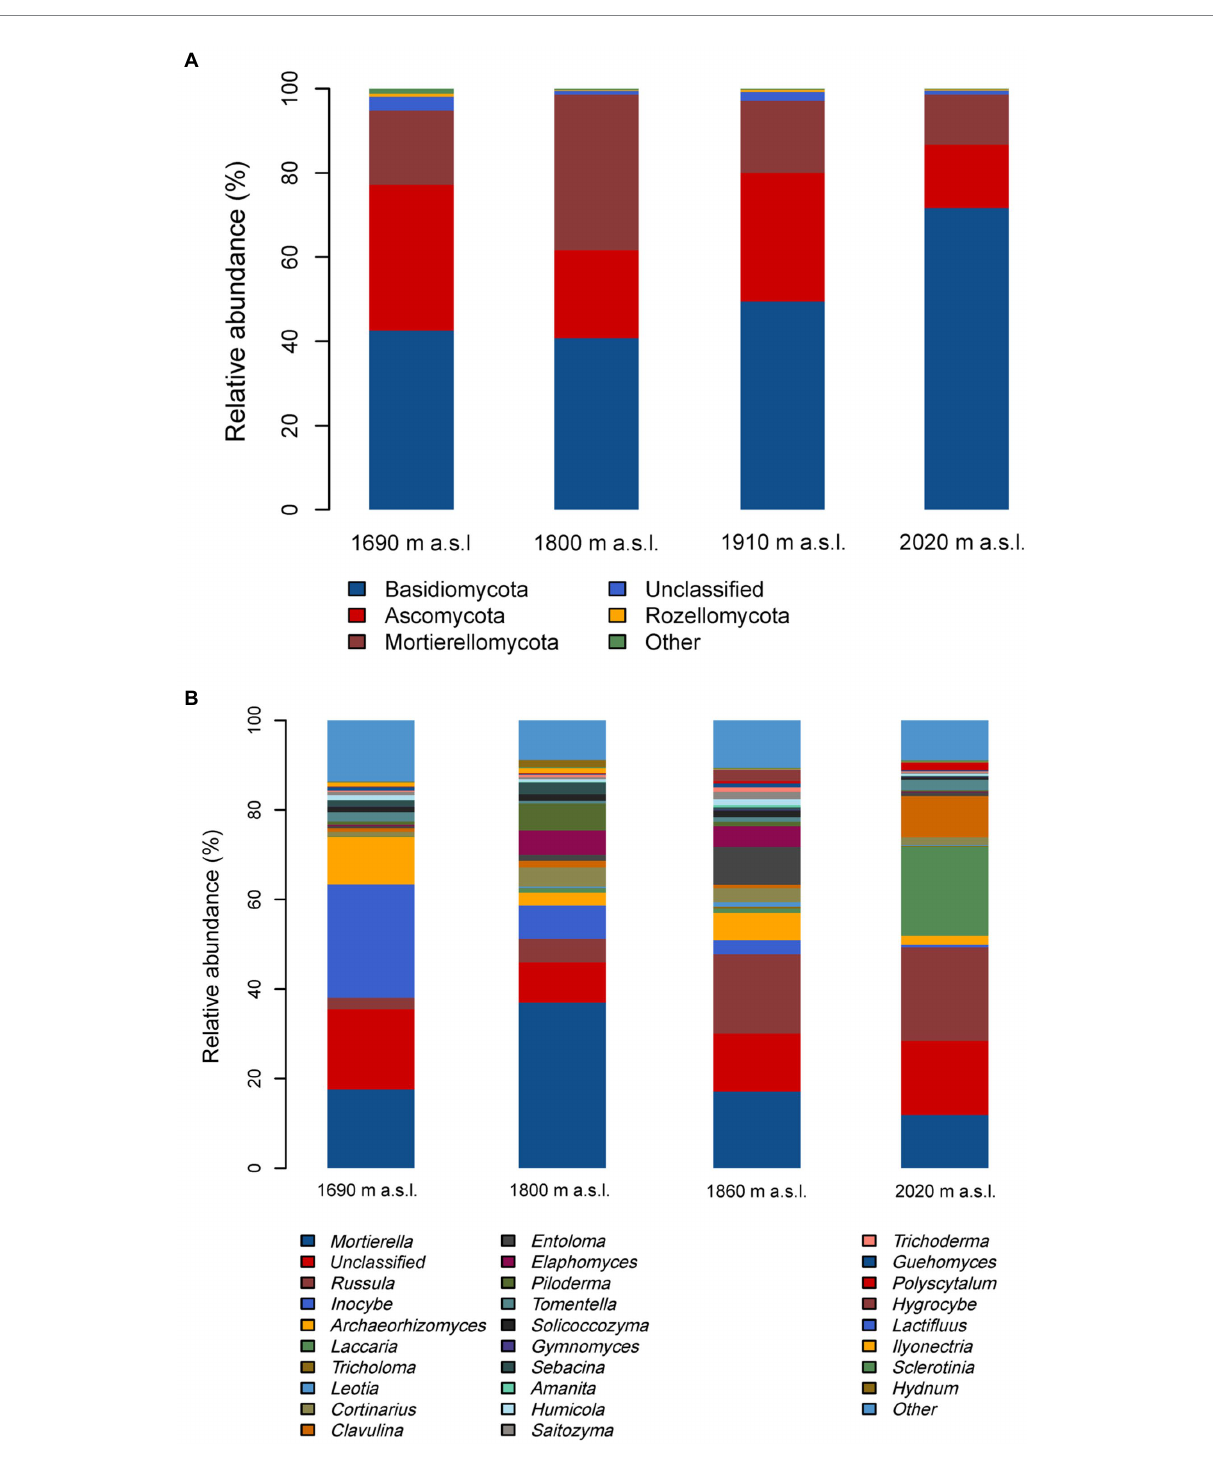
FIGURE 3 Relative abundance of the dominant fungal phyla (A) and genera (B) in soils along an elevational gradient on the Changbai Mountain, northeastern